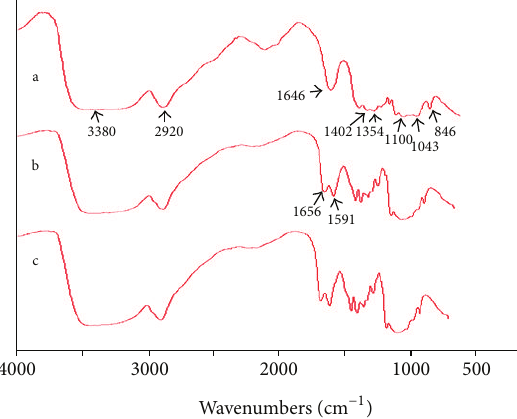
Figure 1: Infrared spectra of cellulose-Fc (a), chitosan-CDs (b), and the inclusion compound